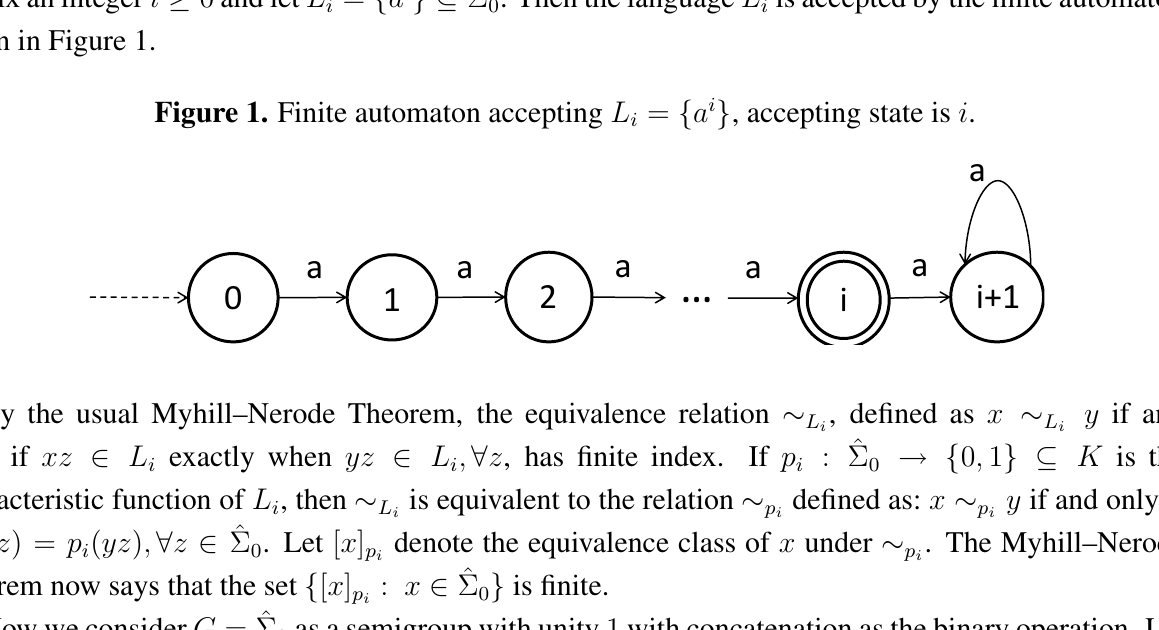
Figure 1. Finite automaton accepting L